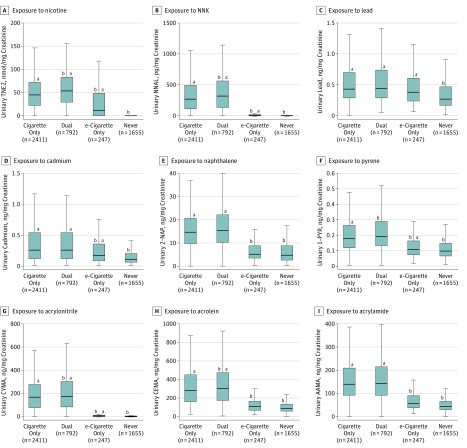
Biomarkers of Exposure Among Dual Users, Cigarette-Only Smokers, e-Cigarette–Only Users, and Never Users, Population Assessment of Tobacco and Health Study, Wave 1, 2013-2014 (N = 5105)Exposure to nicotine (TNE2) (A), tobacco-specific nitrosamine 4-(methylnitrosamino)-1-(3-pyridyl)-1-butanone (NNK) (B), lead (C), cadmium (D), naphthalene (2-naphthol) (2-NAP) (E), pyrene (1-hydroxypyrene) (1-PYR) (F), acrylonitrile (CYMA) (G), acrolein (CEMA) (H), and acrylamide (AAMA) (I). All analyses are weighted. Some volatile organic compound laboratory results were outstanding at the time these analyses were conducted, so weighted estimates may not accurately reflect values in the target population. Box depicts median (interquartile range); whiskers depict minimum and maximum values for creatinine level–corrected biomarker values across tobacco user groups. Outliers excluded from figure to facilitate presentation clarity.aStatistically significant difference from never users adjusted for urinary creatinine level, cigarettes per day, age, sex, race/ethnicity, educational level, secondhand smoke exposure, past 30-day marijuana use, and tobacco use status.bStatistically significant difference cigarette-only users adjusted for urinary creatinine level, cigarettes per day, age, sex, race/ethnicity, educational level, secondhand smoke exposure, past 30-day marijuana use.